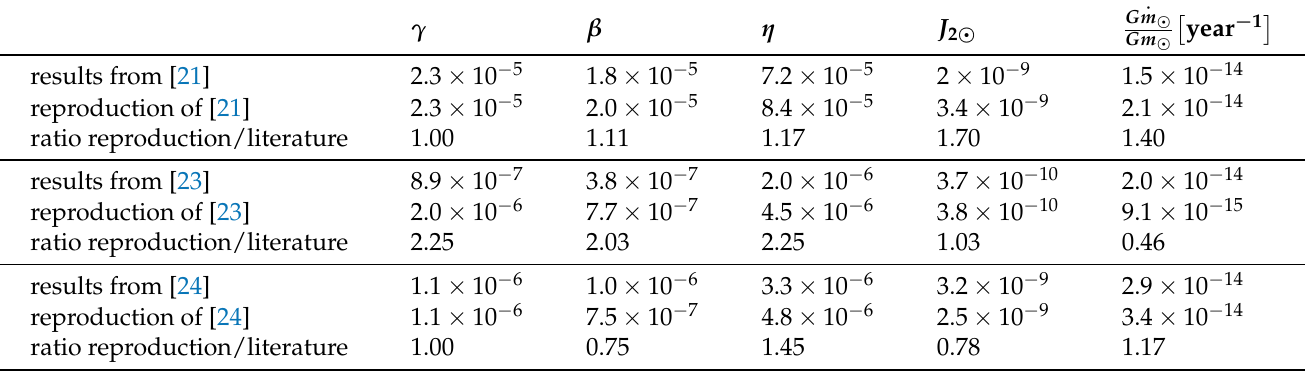
Table 2. Formal uncertainties (1 σ ) reported by recent gravity experiments using tracking data of MESSENGER in the case of [21], or simulated tracking data of BepiColombo in the case of [23,24]. Below each result from literature, a reproduction of the formal uncertainties (1 σ ) of the publications is given, using our software and similar inputs, compared for validation